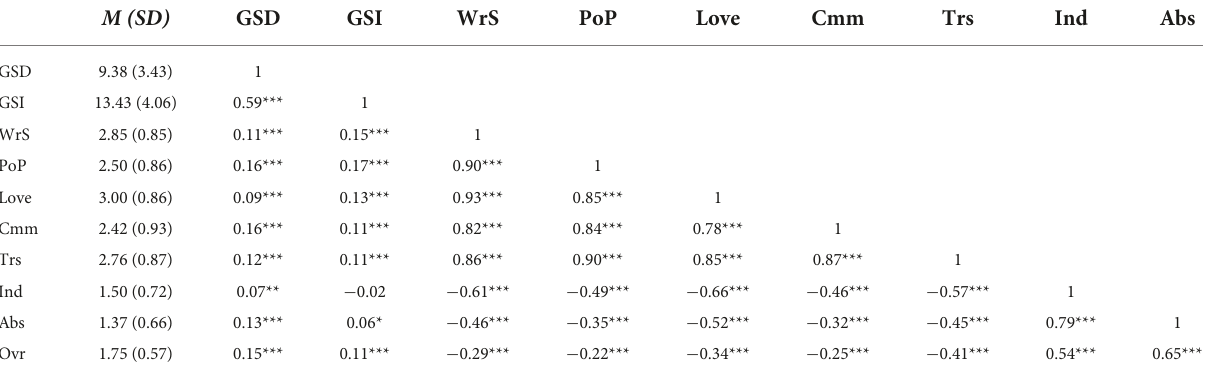
TABLE 2 Means, standard deviations, and bivariate correlations for the English